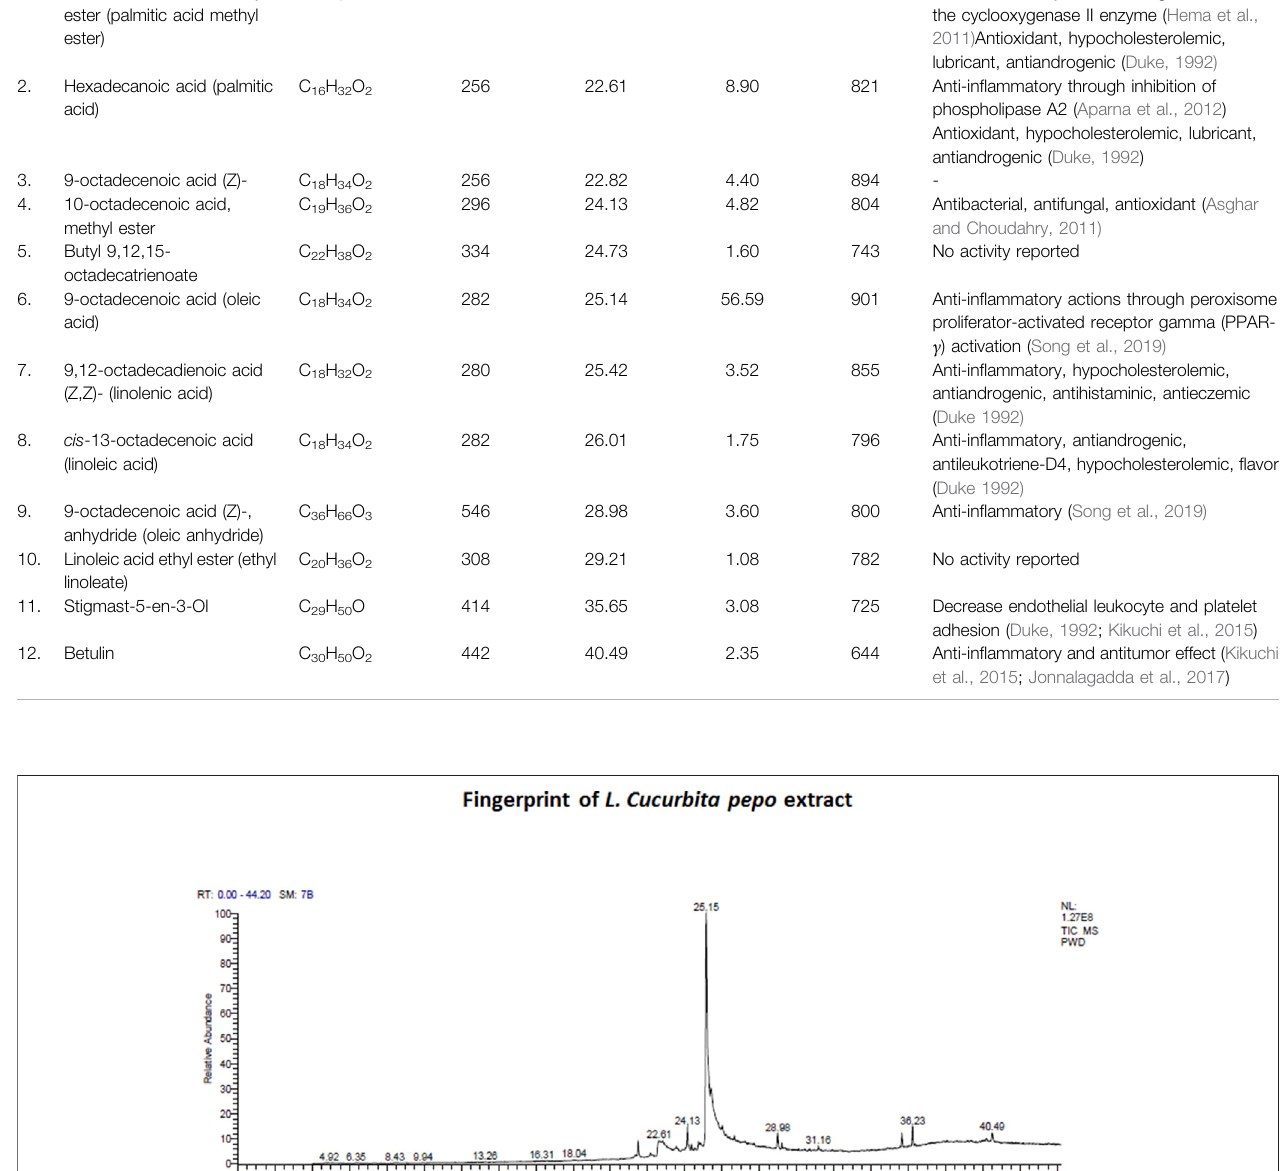
Frontiers in Pharmacology |